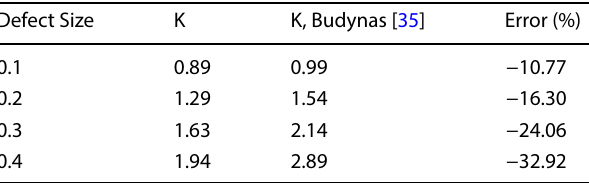
Table 7 2× LR stress intensity factors and errors for pressure vessel configuration 2